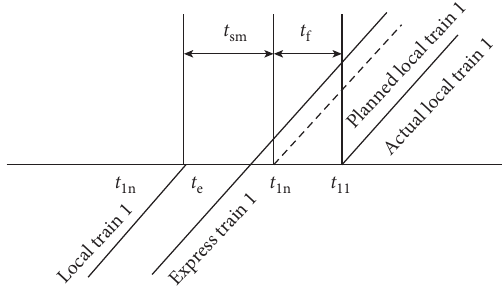
Figure 2: Schematic diagram of the train operation.